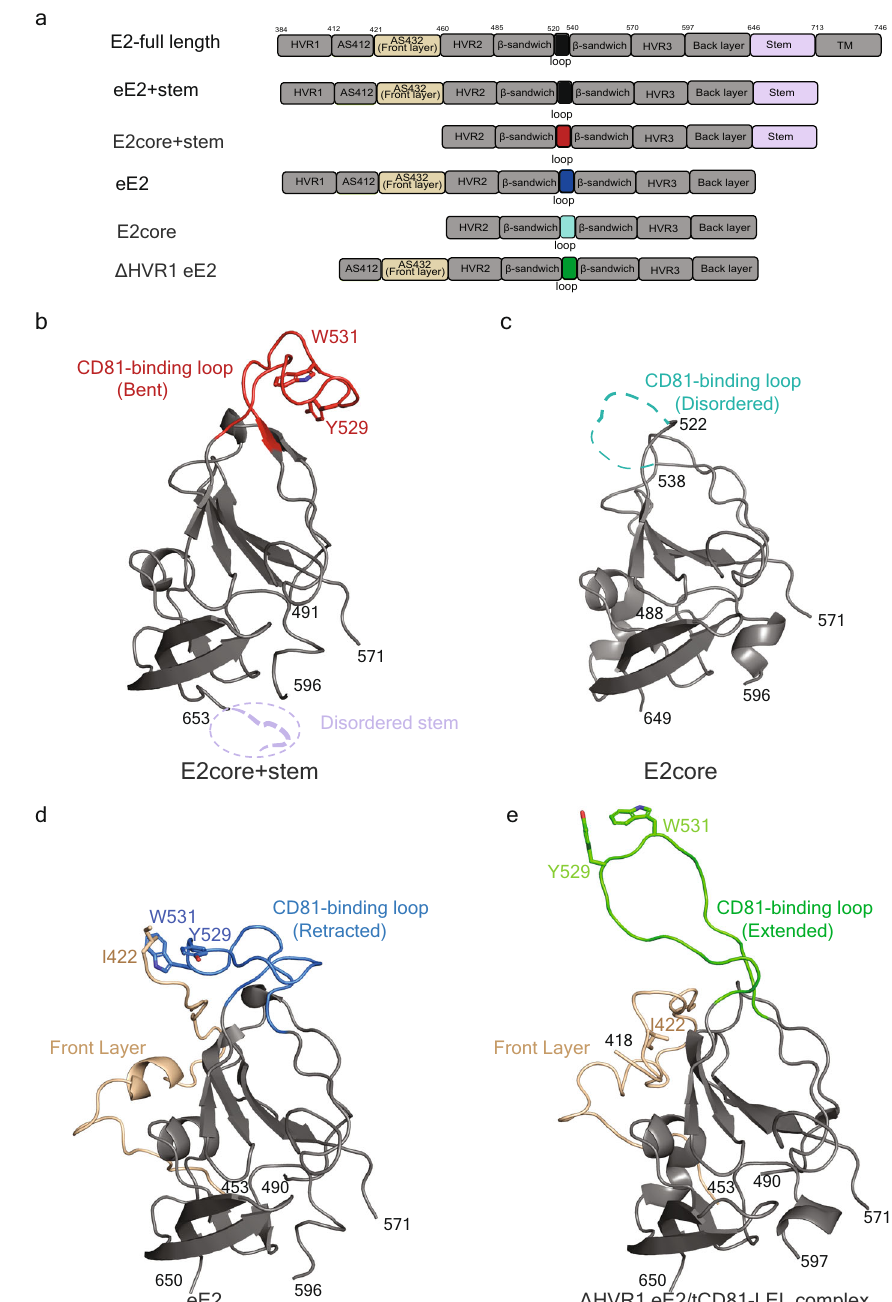
Fig.1|OverviewofHCVE2.a Schematicrepresentationoffull-lengthE2(isolateJ6, genotype 2a), and various fragments used in structural and functional studies. b X-raycrystalstructureofE2core+stem(PDBID:8DK6).The fi nalmodelconsistsof color-codedaccordingto a forE2core+stem,E2core,eE2, Δ HVR1eE2/tCD81-LELand